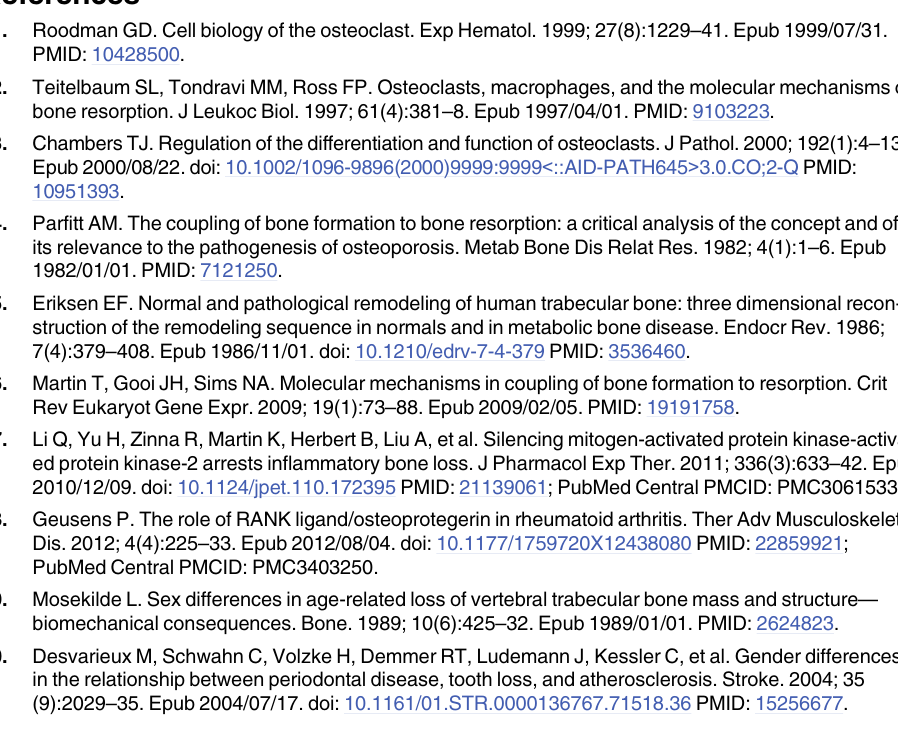
TV) and cortical thickness (Th.) were measured using Scanco Medical Software. Data are ex- pressed as means ± SE compared to Mk2 +/+ controls ( (cid:3) P (cid:1) 0.05, (cid:3)(cid:3) P (cid:1) 0.01, (cid:3)(cid:3)(cid:3) P (cid:1) 0.001) S2 Fig. RANKL stimulates MK2 phosphorylation in dOCP lo pre-osteoclasts. (A-D) Whole images of representative western blots showing the molecular weight ladder. (A) p-MK2 was detected only in Mk2 +/+ samples near 49 kDa of the biotinylated ladder. The two bands de- tected may be different phosphorylated forms of MK2. (B) p-p38 was detected at 43 kDa of the biotinylated ladder. (C) GAPDH was used as the loading control and detected at 37 kDA using the color ladder and transferred to the film (left) or biotinylated ladder (right). (E) Total p38 was detected at 37 kDa using the biotinylated